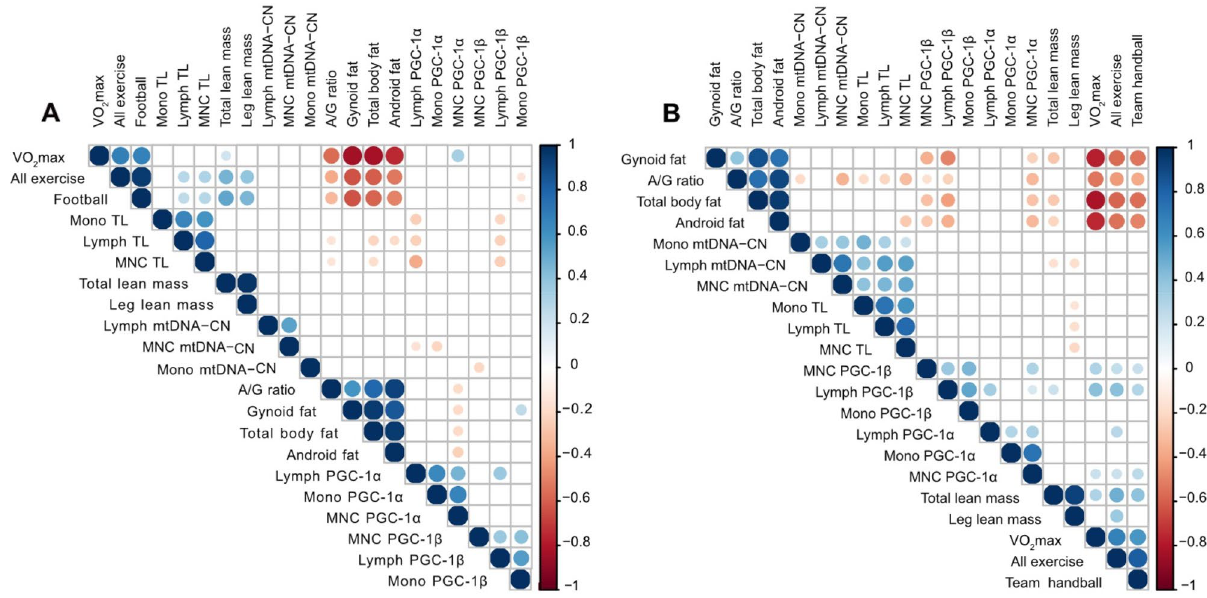
Figure 3. Spearman’s correlations between the investigated variables visualised as arc diagrams in young (18 ‒ 30 years) women ( n = 59) (A) and elderly (60 ‒ 80 years) women ( n = 70) (B) . A/G ratio android/gynoid fat ratio; All exercise hours of weekly exercise of all types; Football hours of weekly football training; Lymph lymphocytes; MNC mononuclear cells; Mono monocytes; mtDNA-CN mitochondrial copy number; Team handball hours of weekly team handball training; TL telomere length; VO 2 max maximal oxygen